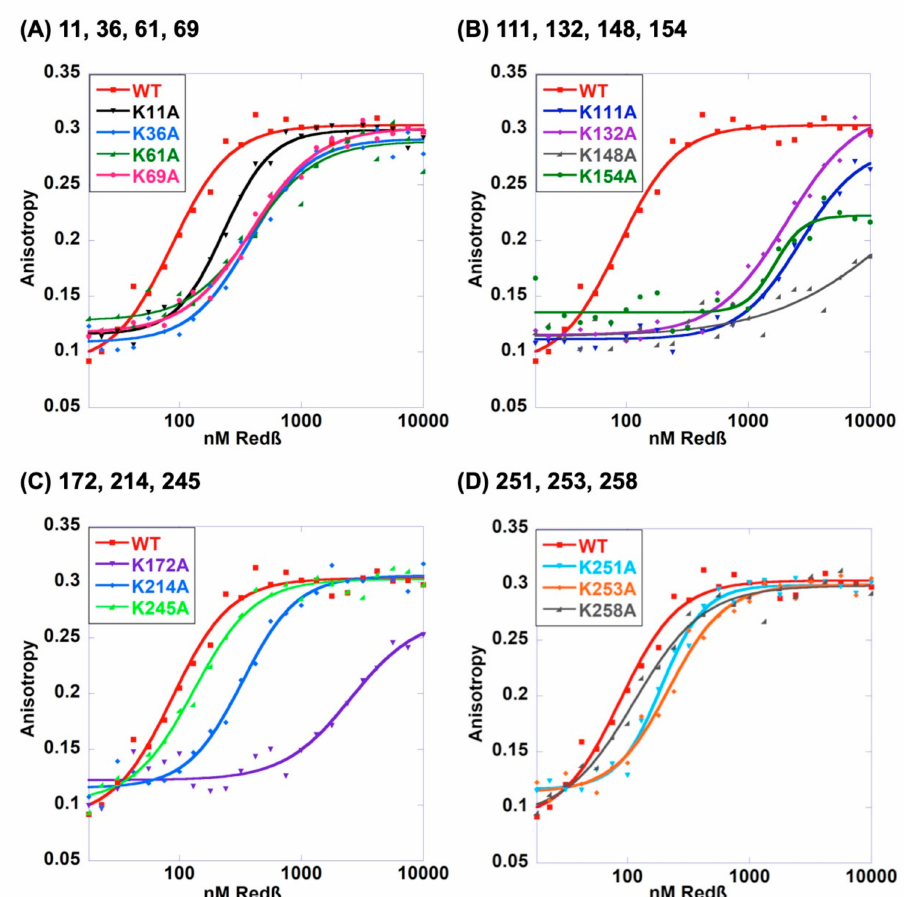
Figure 4. Binding of the 14 Lys to Ala Red β variants to 5’-FAM 48-mer ssDNA. Groups of three or four variants are plotted together with the same data for WT in panels ( A – D ). Each data point shows the average anisotropy value from three replicates at each titration point. The solid lines represent the fit of the averaged data points at all concentrations for each titration to the Hill equation, as described in Materials and Methods. The apparent K d values reported in Table 1 are the mean ± SD values from three independent titrations, one of which, that giving the middle value, is shown